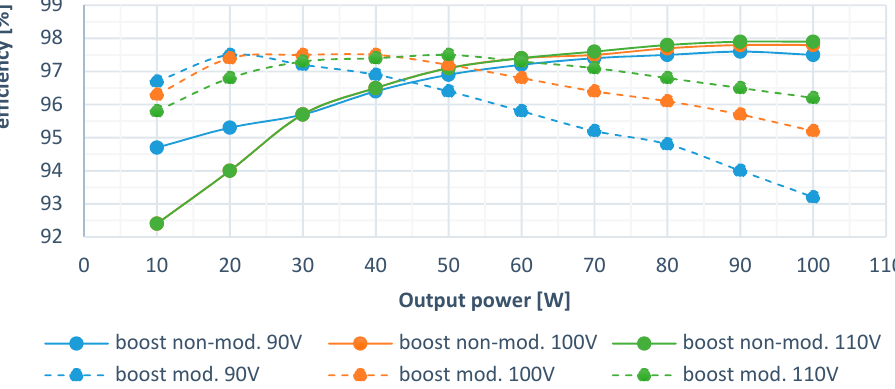
Figure 14. The dependency of efficiency on output power and input voltage for proposed bi-BB converters for boost mode.